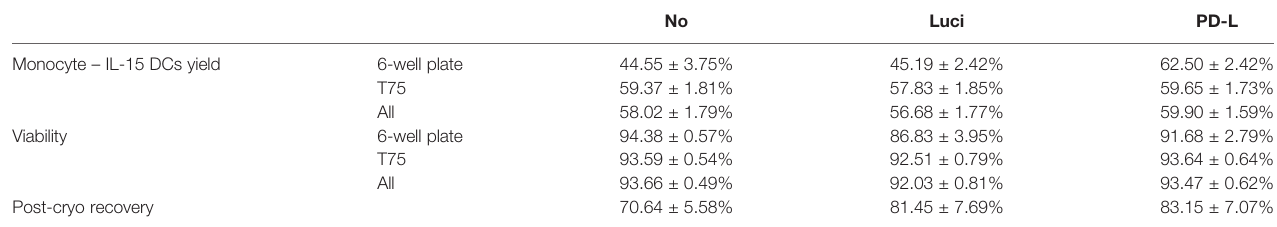
TABLE 2 | Summary of yield, viability and post-cryopreservation (cryo) recovery of no siRNA IL-15 DCs (no), luciferase siRNA IL-15 DCs (luci) and PD-L siRNA IL-15 DCs (PD-L) cultured in 6-well plates or T75 fl asks. Values are expressed as mean ± SEM. No Luci PD-L Monocyte – IL-15 DCs